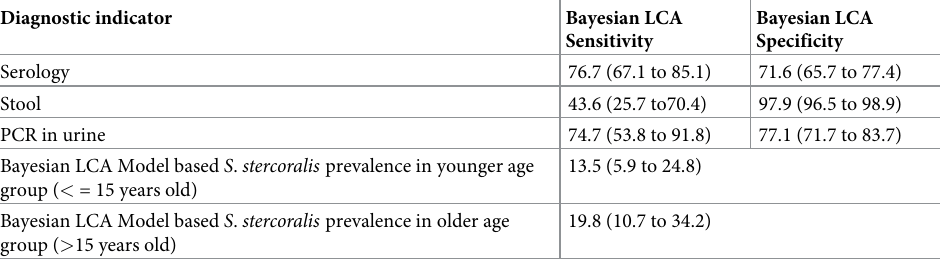
Table 3. Bayesian LCA estimates of sensitivity and specificity and Strongyloidesstercoralis prevalence with 95% Credible Intervals (CrIs) for results of three diagnostic tests (n =